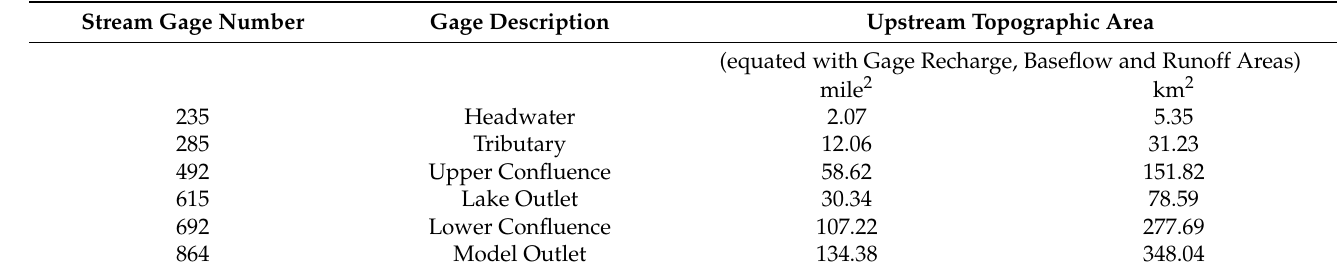
Table 1. Topographic areas upstream of stream gages identified in Figure